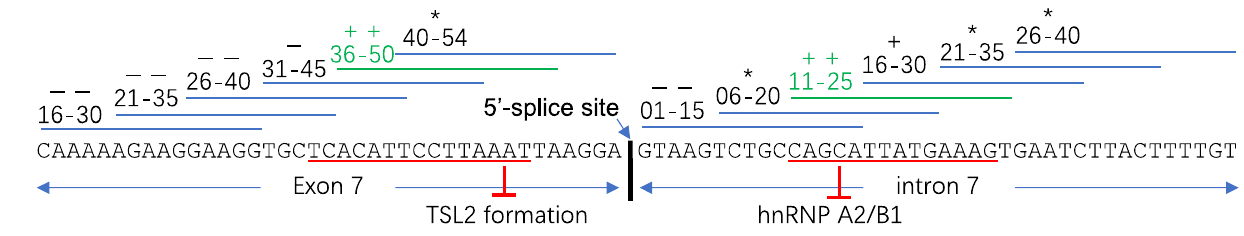
Figure 9. Binding sites for the ASOs used in the SMN2 exon 7 and intron 7 walk. The position of complementarity of each ASO along the sequence of interest is indicated by a horizontal line. +: promotion of the exon 7 inclusion, − : inhibition of the exon 7 inclusion, *: no effect on alternative splicing. The figure is modified from refs [101,153] (copyright © 2021 Hua et al. [153]; © 2021 The American Society of Human Genetics [101]). The “ASO walking” experiment determined the splicing silencer elements (red underline).